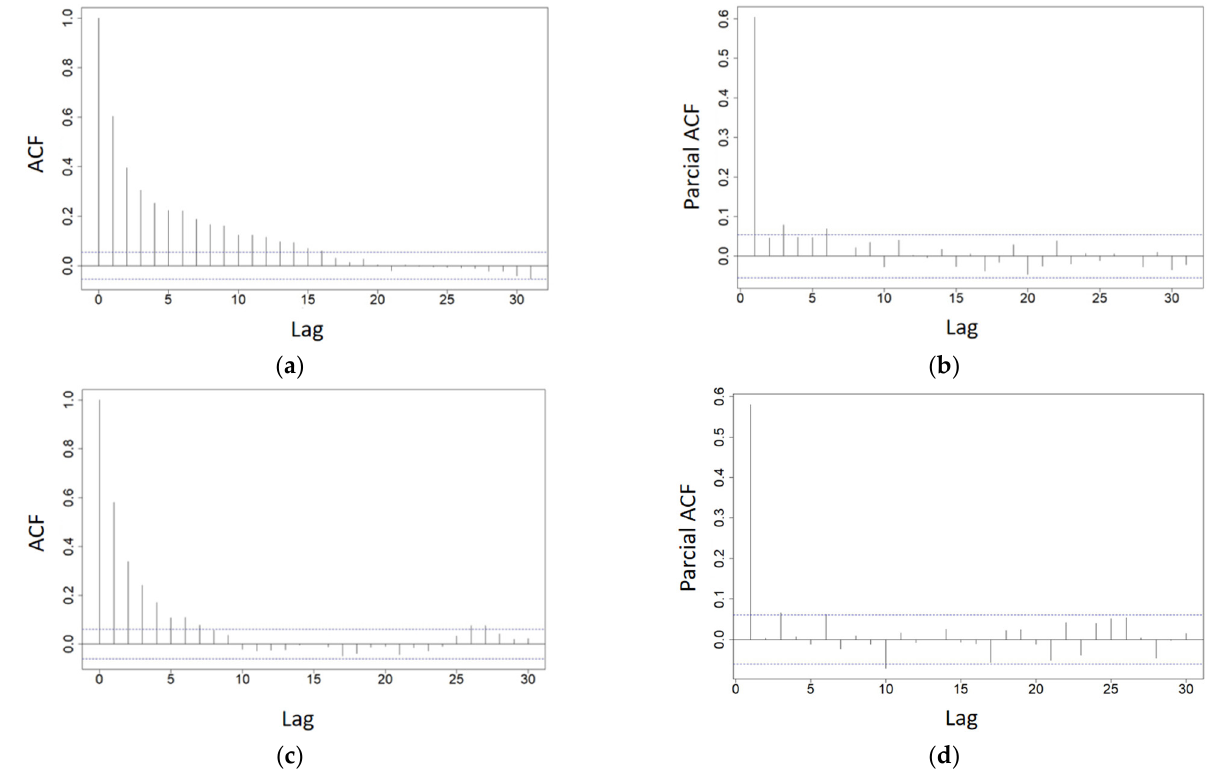
Figure 16. Autocorrelation and partial autocorrelation characteristics of remainder component. ( a,b ) Original calibration coefficient data and ( c , d ) calibration coefficient data without first 250 days.